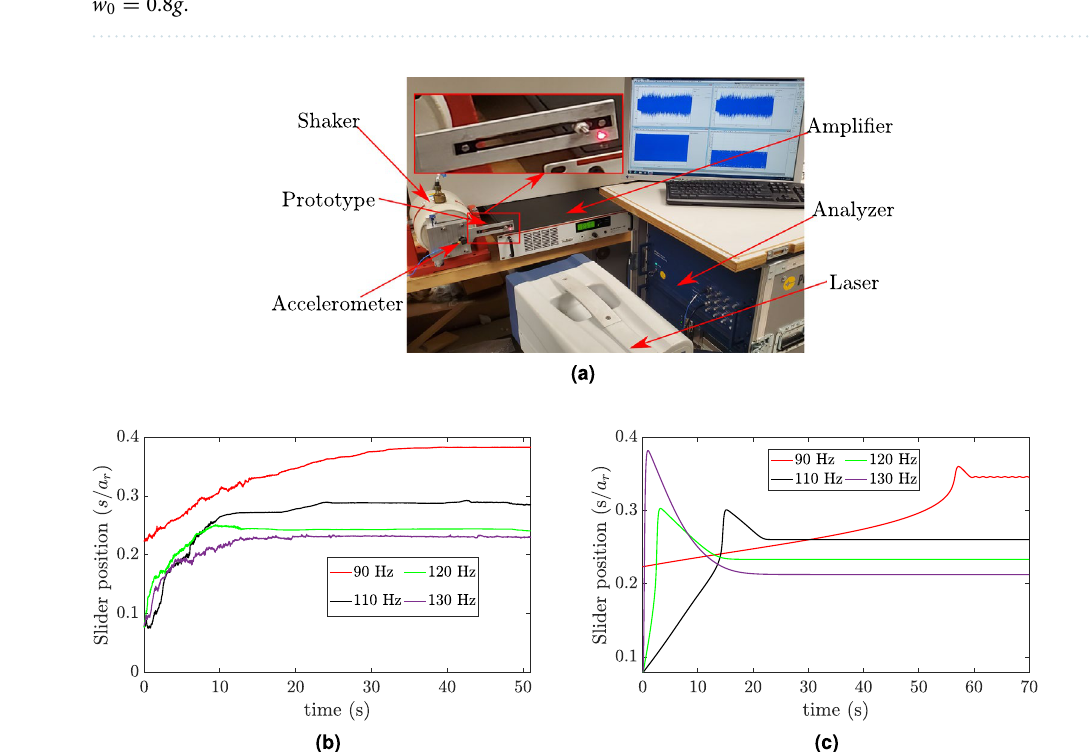
Figure 9. ( a ) Key components of the experimental setup; ( b ) Measured slider position at different excitation frequencies; ( c ) Analytical slider position at different excitation